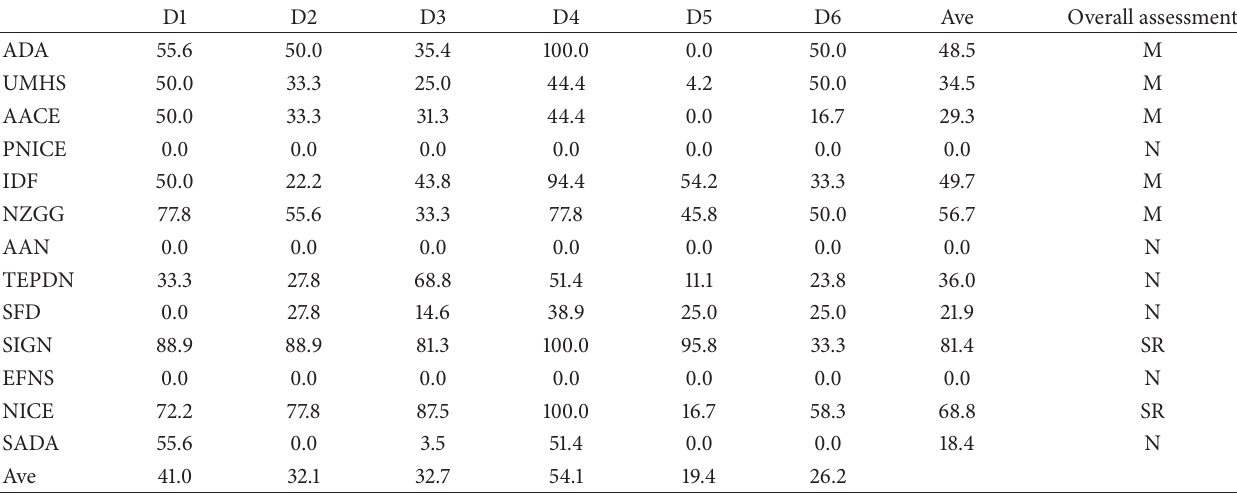
Table 5: Results of the assessment of recommendations regarding the avoidance of risk factors and complications using the AGREE II instrument (domain scores in %).